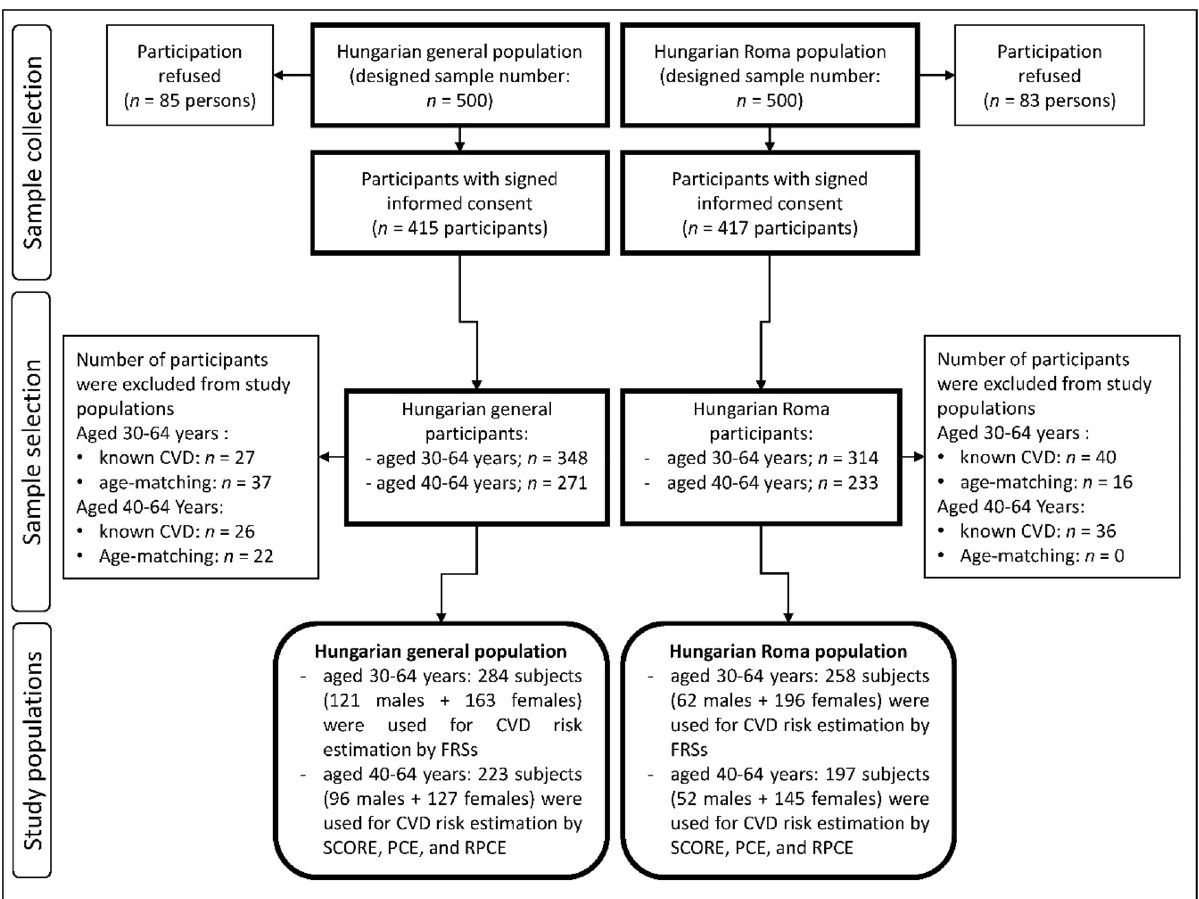
Figure 1. Flowchart showing the process of sample selection for study populations.